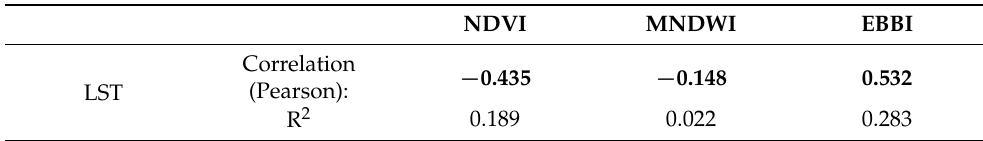
Table 7. Pearson correlation between the annual rate of change in the LST and the annual rate of change in the NDVI, MNDWI and EBBI indices (1987–2019). NDVI MNDWI EBBI Correlation − 0.435 − 0.148 0.532 (Pearson): LST R 2 0.189 0.022 0.283 Values in bold are different from 0 with a significance level alpha = 0.05.